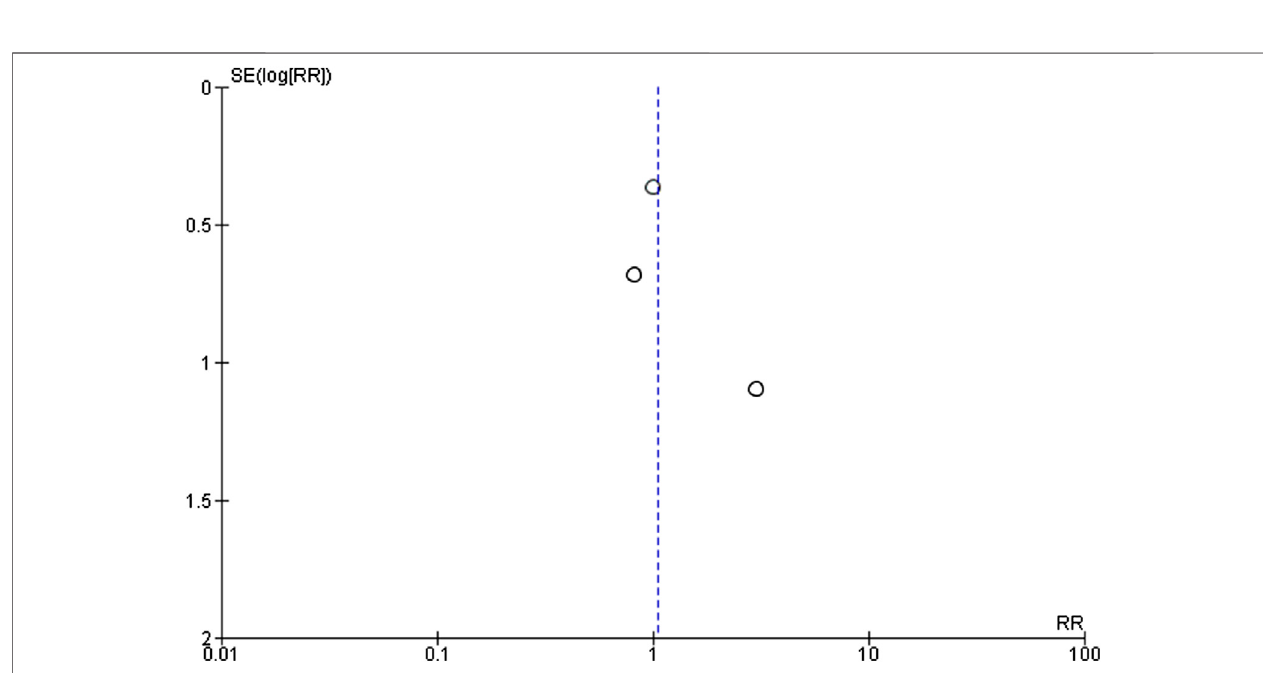
FIGURE 4 | Funnel plot for ef fi cacy of opioid agonists and antagonists in pain reduction in trials included in the meta-analysis.